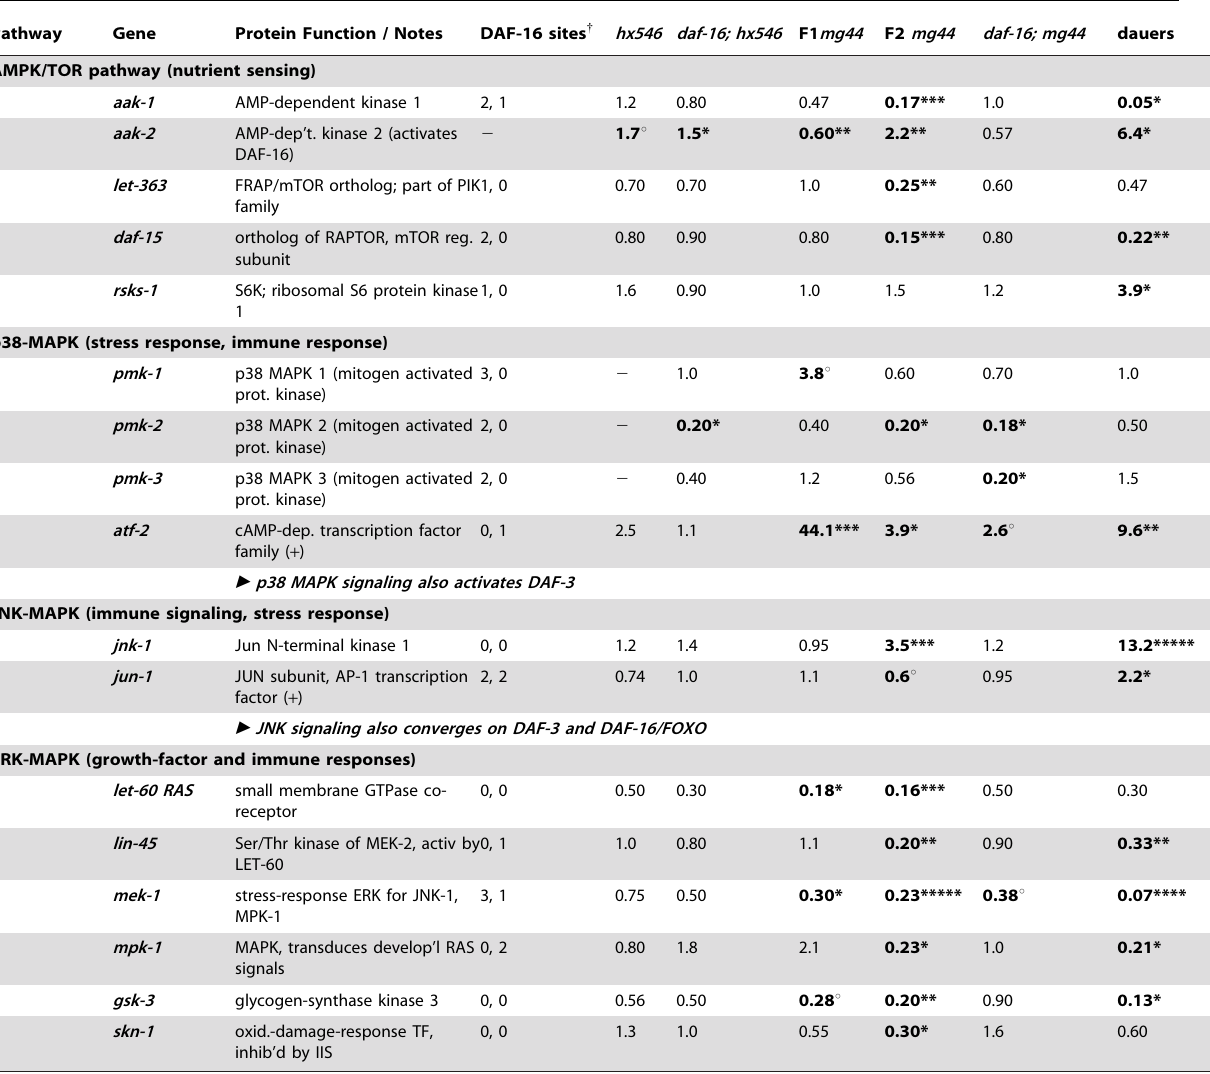
Key: 2 , not assessed. Significance of difference from N2DRM (by 2-tailed t -test): u , nominally significant at P , 0.05. *, P , 0.01; **, P , 0.001; ***, P , 1E 2 4; ****, P , 1E 2 5, *****, P , 1E 2 6. { Number of exact consensus DAF-16 sites in upstream 5-kb span, (a, b), where a =GTAAA(C/A)AA, and b =CTTATCA. For each gene tested, wild-type N2DRM adults are compared to four age-1 mutant populations and to dauer larvae. The a ge-1(mg44) worms are F1 homozygotes at days 8–9 of adulthood, by which time they were post-gravid, or F2 homozygotes at day 10 (18 days post-hatch); other groups (N2DRM, age-1(hx546) , and daf-16(mu86) ; age-1(mg44) double mutants) were harvested when post-gravid (days 6–8 of adulthood), or as dauer larvae (N2DRM only) from starved, dense cultures 1 day after . 98% of worms had become resistant to lysis by 1% sodium dodecyl sulfate. Transcript levels were assayed for 3–8 independent biological replicates, with two cDNA syntheses and RT-PCRs for each. Numbers shown are transcript ratios for each group indicated (in the column header) relative to transcript levels of the same genes in near-isogenic N2DRM controls. All C(t) data (threshold cycle numbers) were normalized to the mean values for three control genes ( b -actin, T08G5.3, and Y71D11.3) that did not change among the strains/groups tested. Changes that were at least nominally significant ( P , 0.05) are emphasized with bold font. doi:10.1371/journal.pgen.1000452.t001 ins-7 (the only confirmed IIS agonist) is downregulated. Genes phosphatase PTEN, and par-5 , encoding one of several 14-3-3 proteins that sequester IIS-phosphorylated DAF-16—genes that supplying the IIS kinase cascade that inactivates DAF-16/FOXO arguably are superfluous in the absence of PIP 3 and IIS-mediated ( daf-2 , age-1 , sgk-1 , and pdk-1 ) are all downregulated, whereas ist-1 , encoding a homolog of mammalian IRS-1 and IRS-2 [41] which phosphorylation of DAF-16, respectively. serve as convergence points for many inhibitory inputs from other Other signal transduction genes. In view of the global suppression of kinase activities (Figure 1), we extended the signaling pathways [41,42], is upregulated. Moreover, aak-2 , the transcriptional assay panel to include non-IIS kinases and other sole AMP-dependent kinase (AMPK) gene implicated in DAF-16/ FOXO activation [43,44], and shown to extend lifespan when signal-transduction genes (Table 1). The TGF- b and ERK/ MAPK (mitogen-activated protein kinase) signaling pathways, over-expressed [45], is upregulated in age-1(mg44) F2 adults (Table 1). Apparent exceptions include the low transcript levels silenced, with 3 and 6 genes (respectively) downregulated by more for two genes that antagonize IIS: daf-18 , encoding the PIP 3 3-